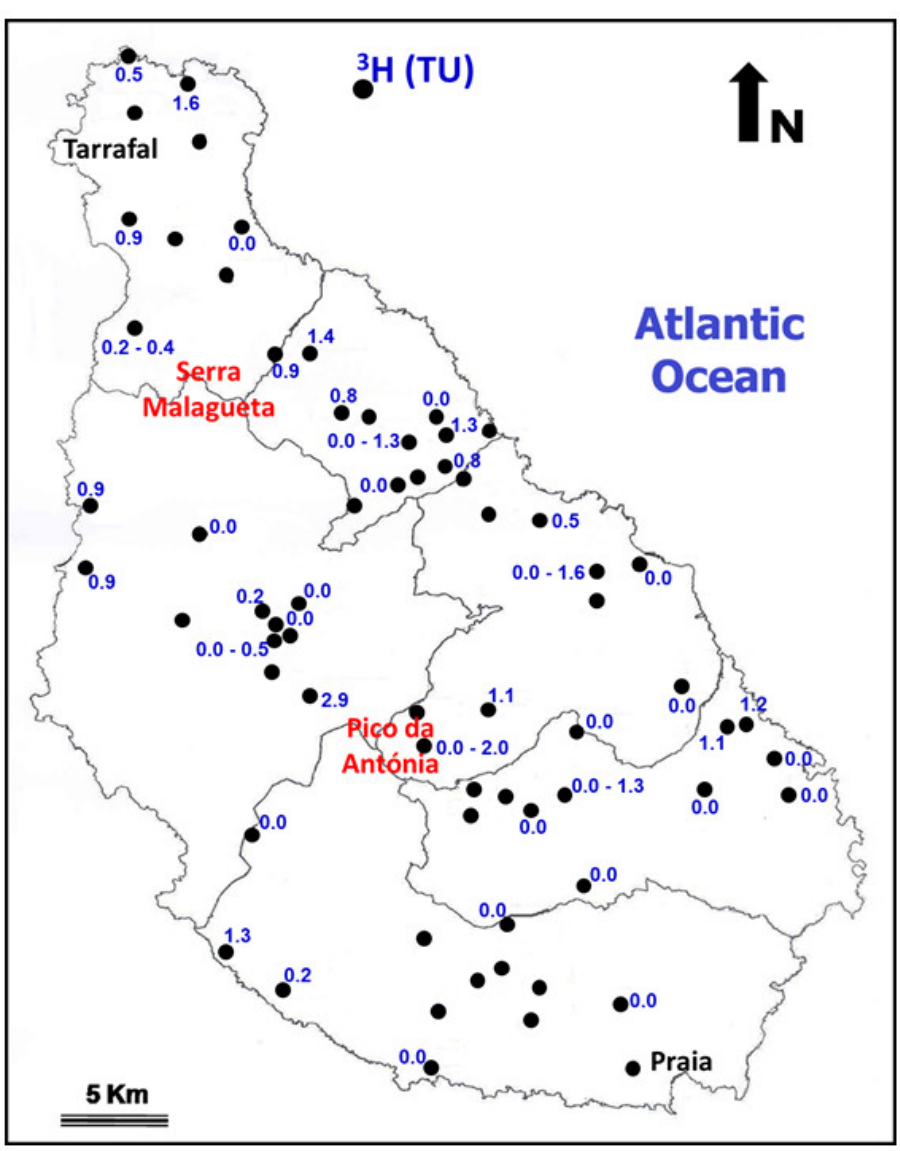
Figure 10. Schematic map of Santiago Island, with the tritium content in TU, adapted from [57]. Carbon-14 measurements were performed only in six groundwater samples from the Middle Unit. The 14 C content in groundwater allows dating “old” water